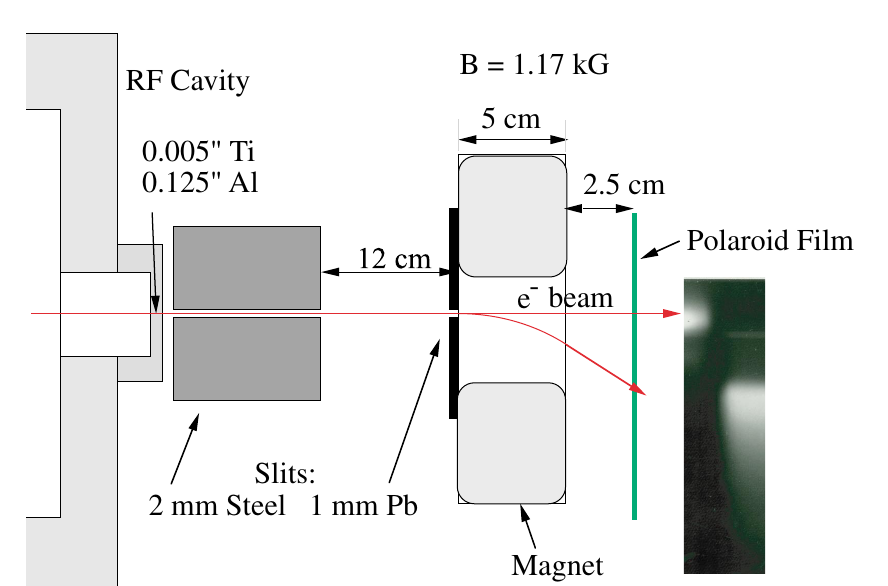
FIG. 7. (Color) The magnetic spectrometer used for dark current energy